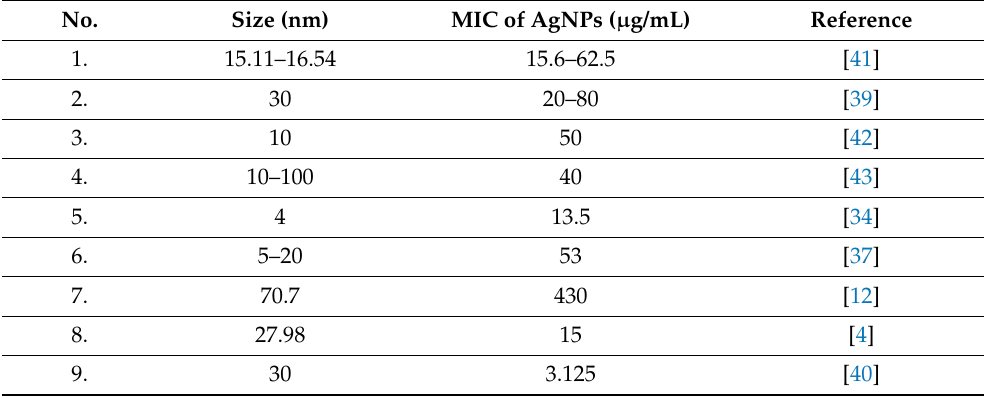
Table 5. Selected studies on the antibacterial activity of silver nanoparticles to S. aureus .